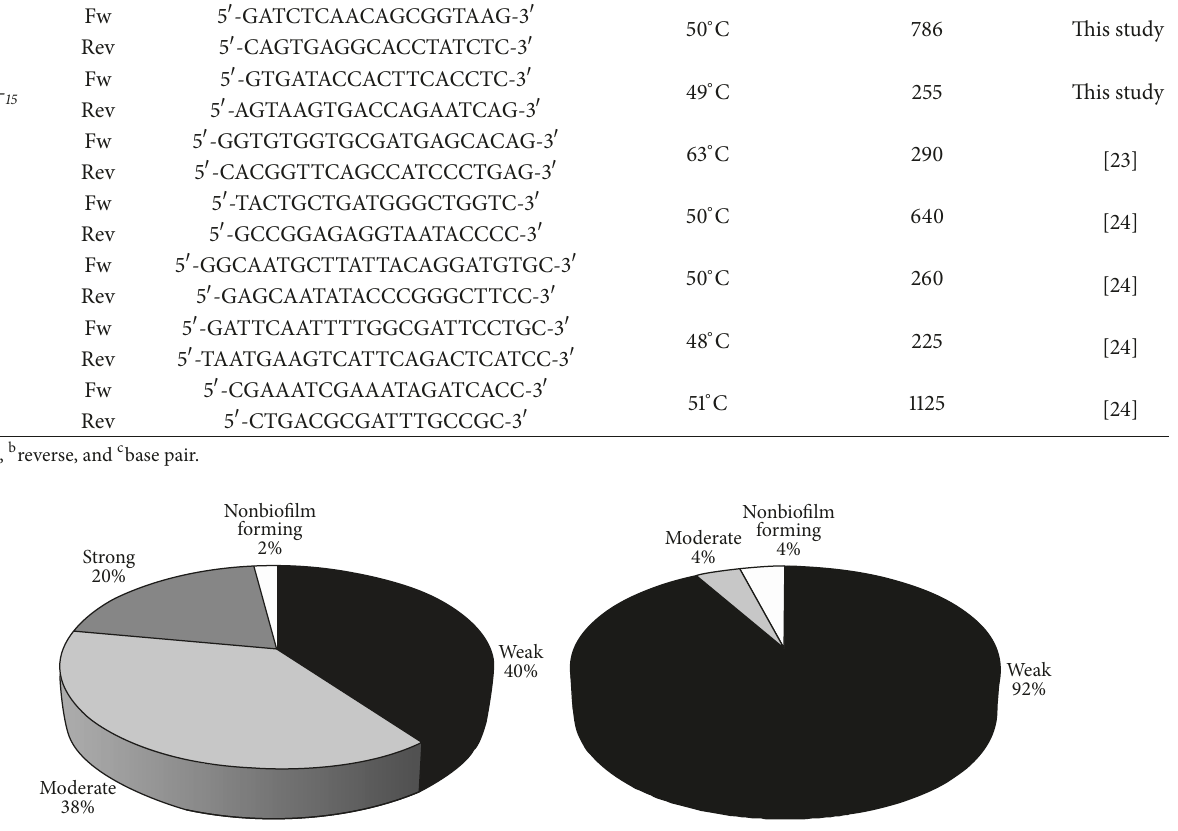
Aerobactin gene ( iucA ) was detected in 6 (12%) of ESBLs and 3 (6%) of non-ESBL producing